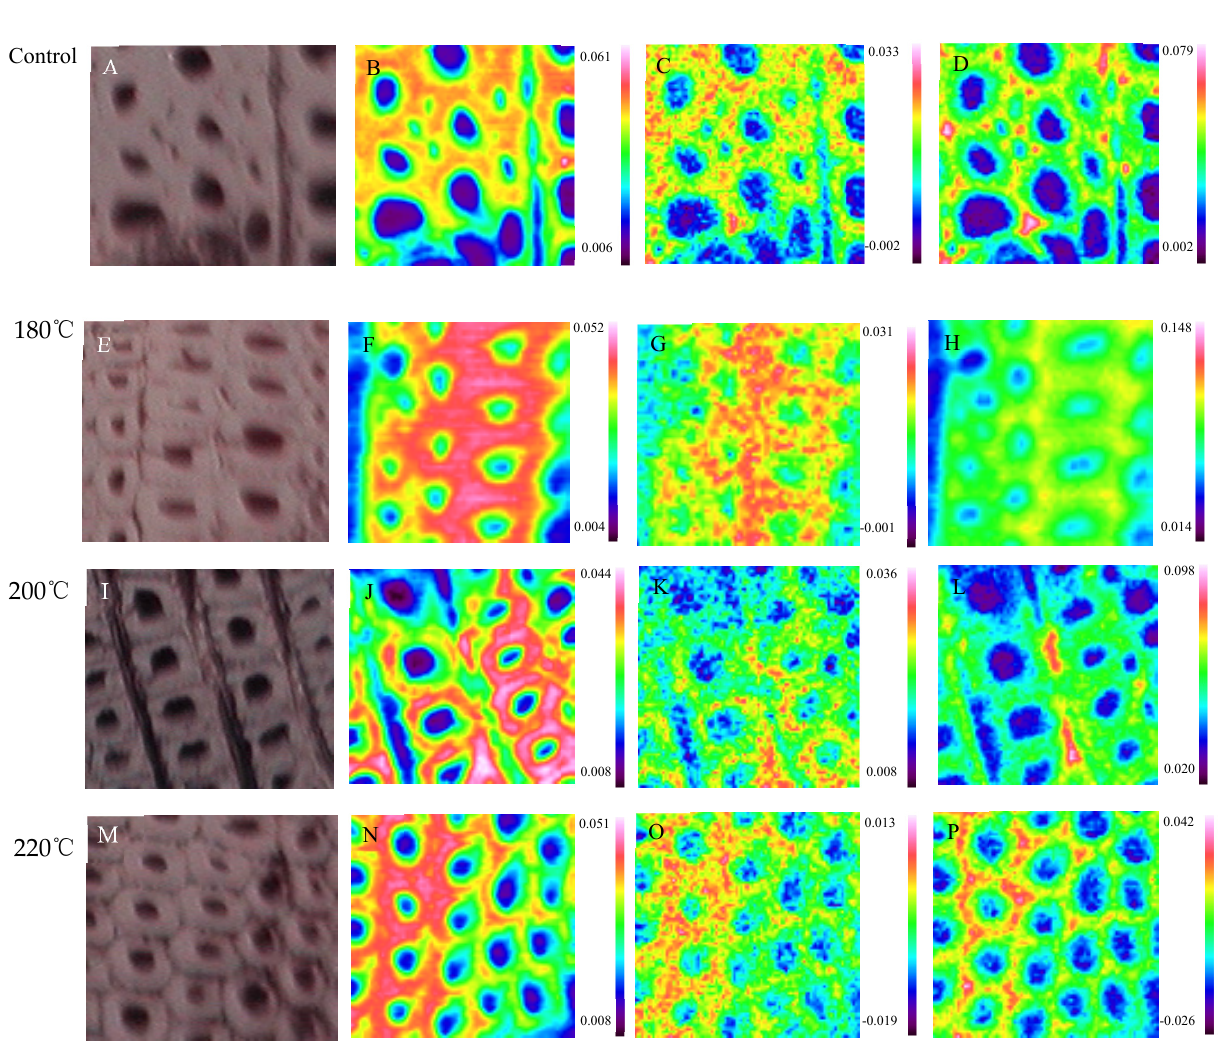
Figure 9. Visual images ( A , E , I , M ), total absorbance images ( B , F , J , N ), and single wavenumber im- ages of LW before and after vacuum heat treatment. Spectral images generated with the peak at 1734 cm − 1 ( C , G , K , O ), spectral images generated with the peak at 1508 cm − 1 ( D , H , L , P ). Table 3. Elastic modulus and hardness values of untreated and vacuum heat-treated wood cell wall as determined by quasi-static